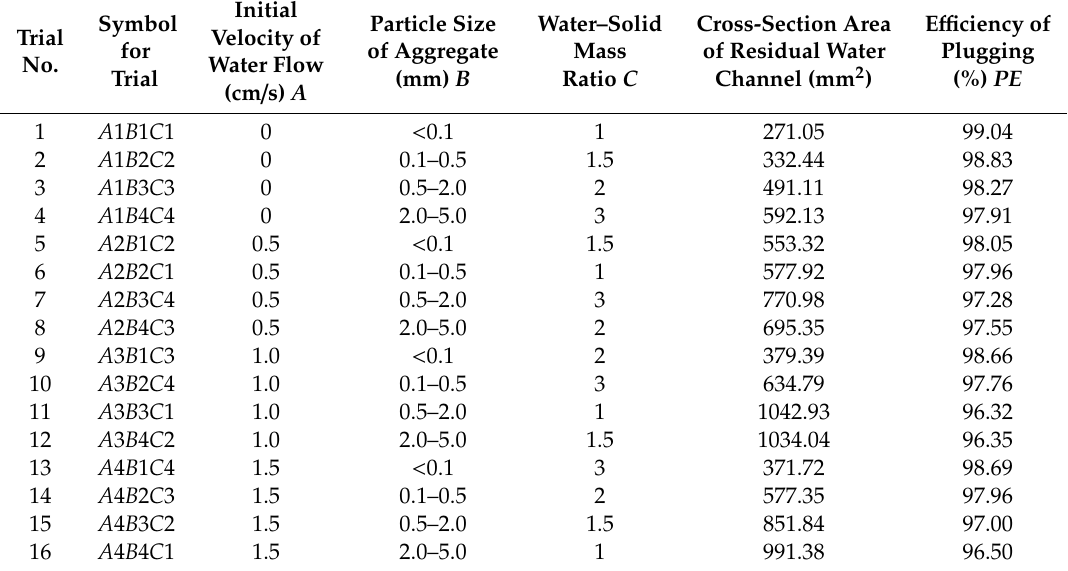
Table 2. Orthogonal experimental matrix on modeling of pouring aggregate into